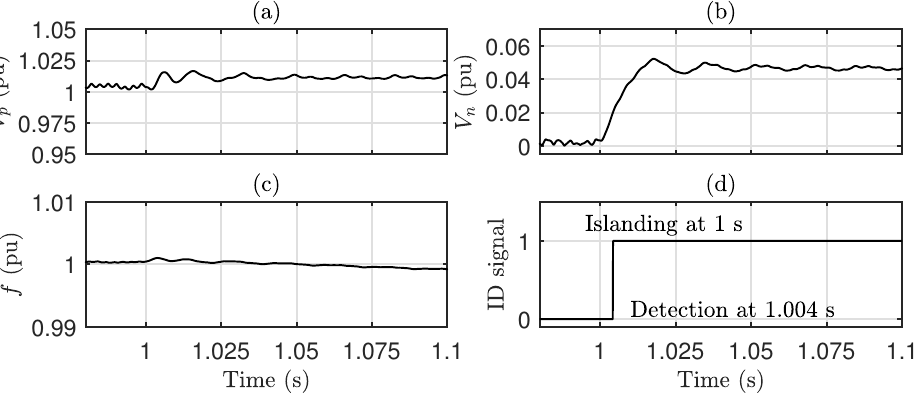
Figure 15. LCL -type filter case: Performance under 100% increase in L g : ( a , b ) estimated magnitudes of positive- and negative-sequence PCC voltage, respectively; ( c ) estimated frequency; and ( d ) ID